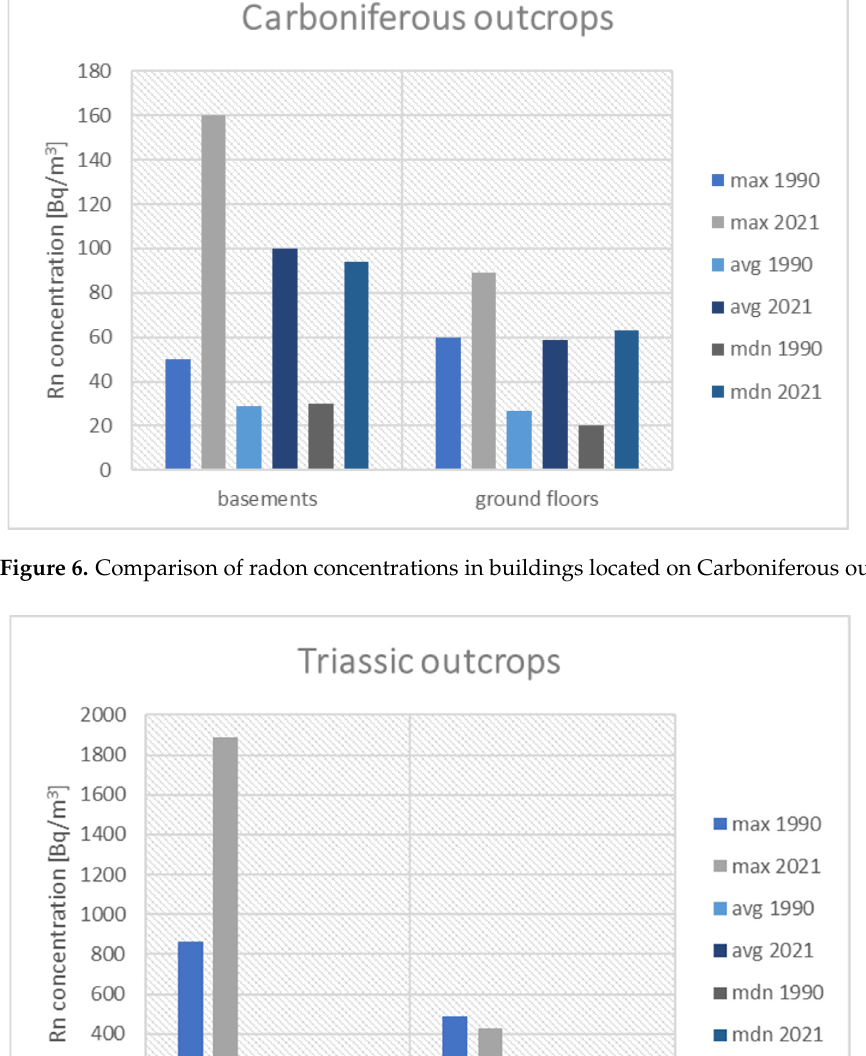
Figure 8. Comparison of radon concentrations in buildings located on Quaternary sediments.